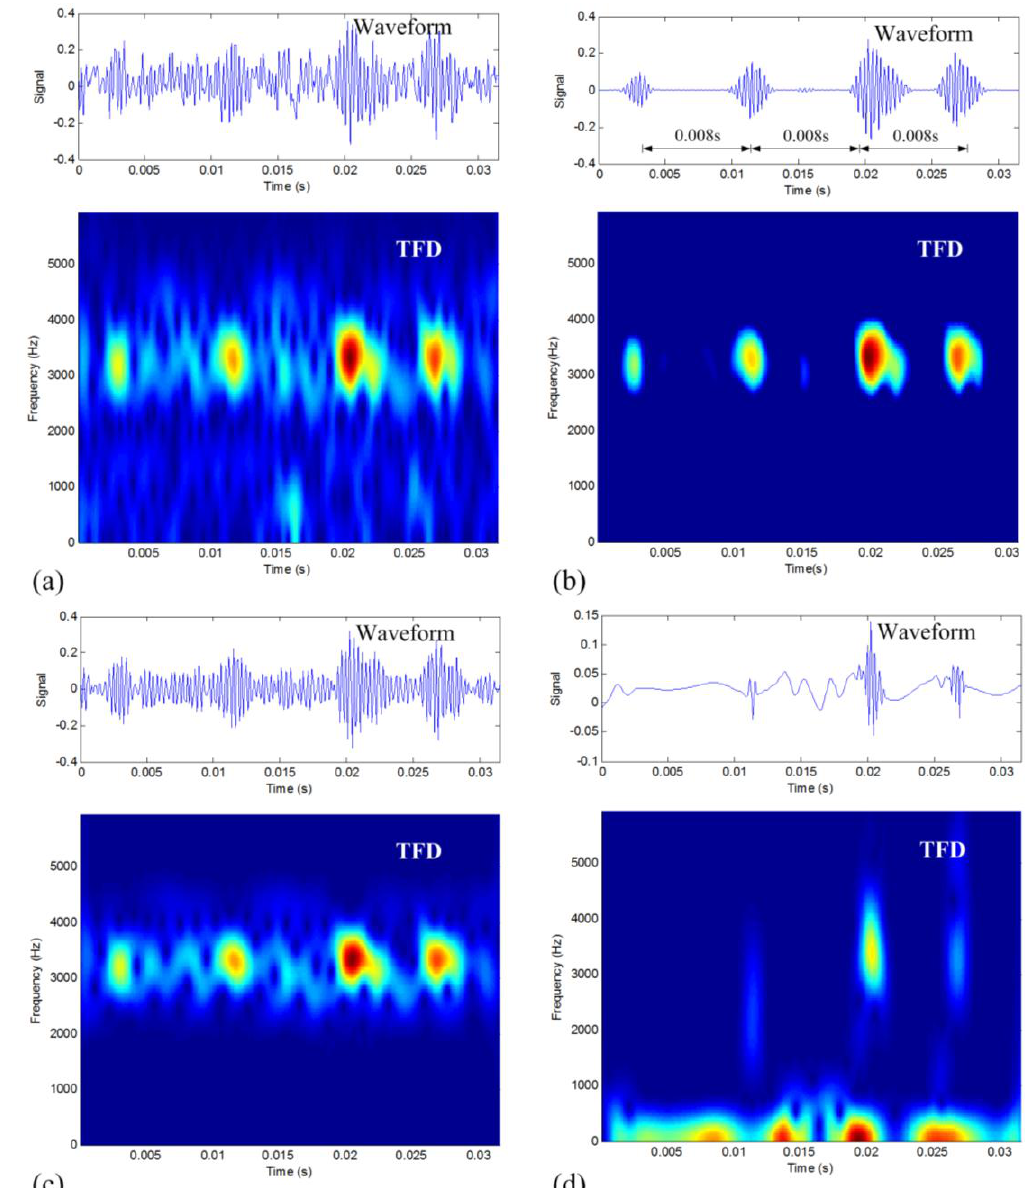
Figure 7. Denoising results of the rolling-element defective vibration signal: ( a ) original raw signal; ( b ) the TFM-based denoising result; ( c ) band-pass filtering result; and ( d ) DWT-based denoising